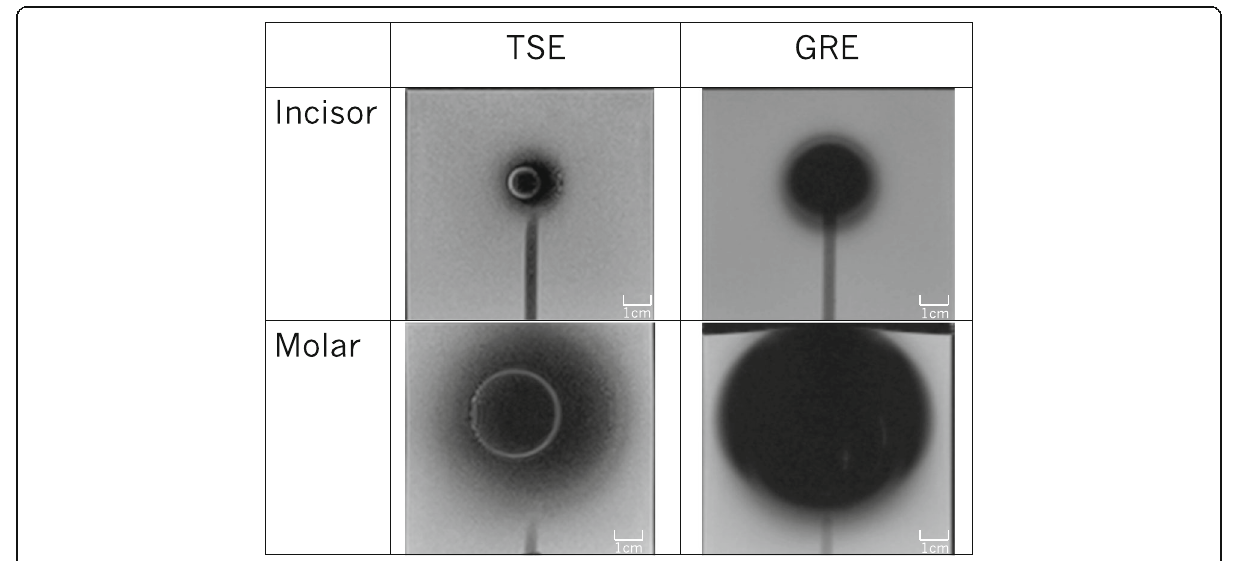
Fig. 7 Magnetic resonance images of incisor and molar brackets taken with turbo spin echo (TSE) and gradient echo (GRE) sequences